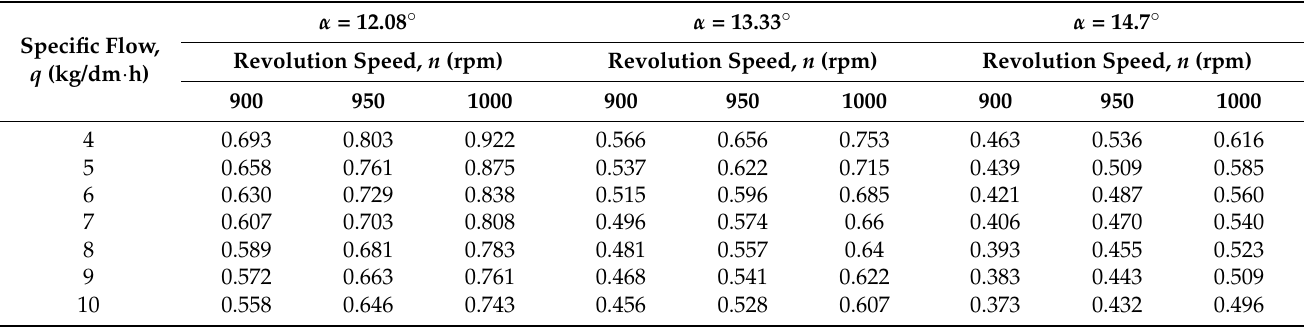
Table 7. Average separation coefficient calculated for nettle for different flow